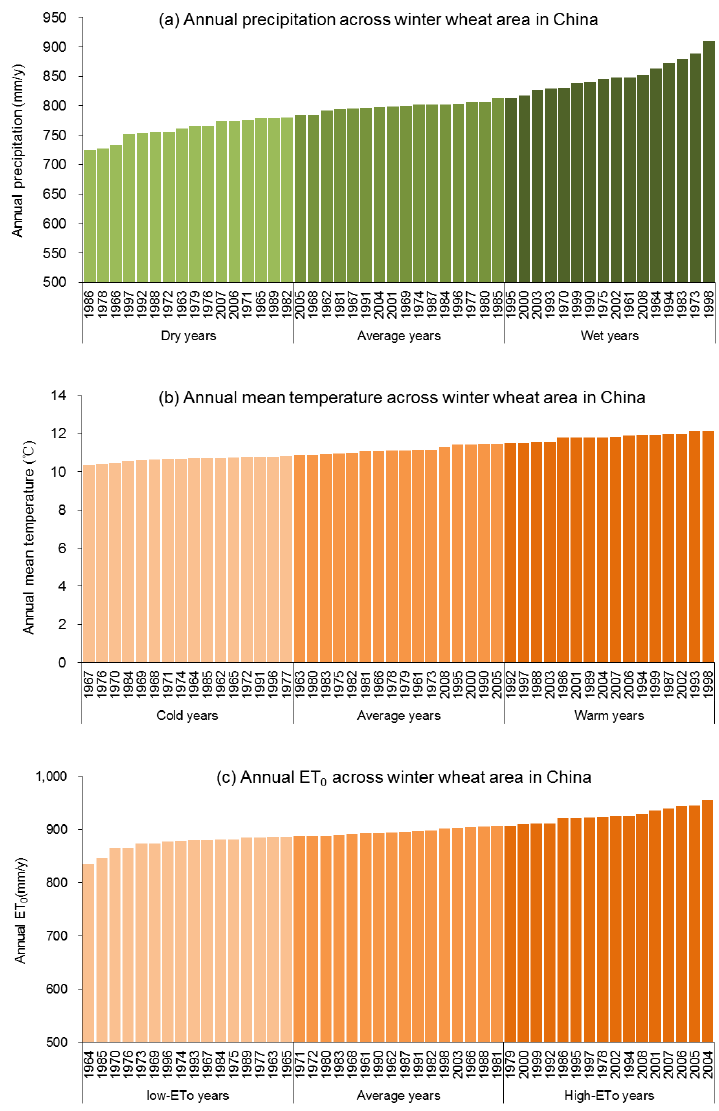
Figure 2. Annual precipitation (a) , mean temperature (b) , and ET 0 (c) over the cropping area of winter wheat in China for the years in the period 1961–2008, ranked from lowest to highest values. Data source: Harris et al. (2014). Table 1. Soil